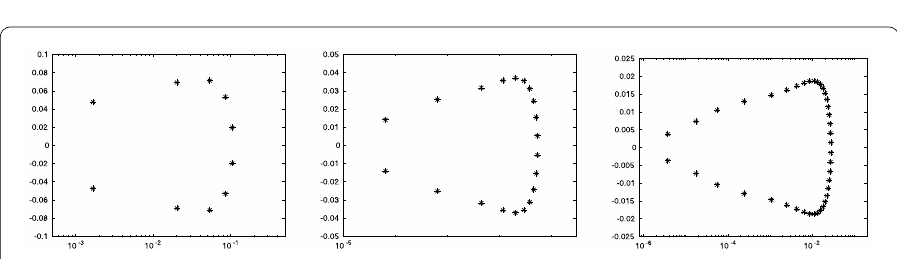
Figure 2 Eigenvalues of the matrix V n for a logarithmic weight function and n = 10,20,40 (from left to